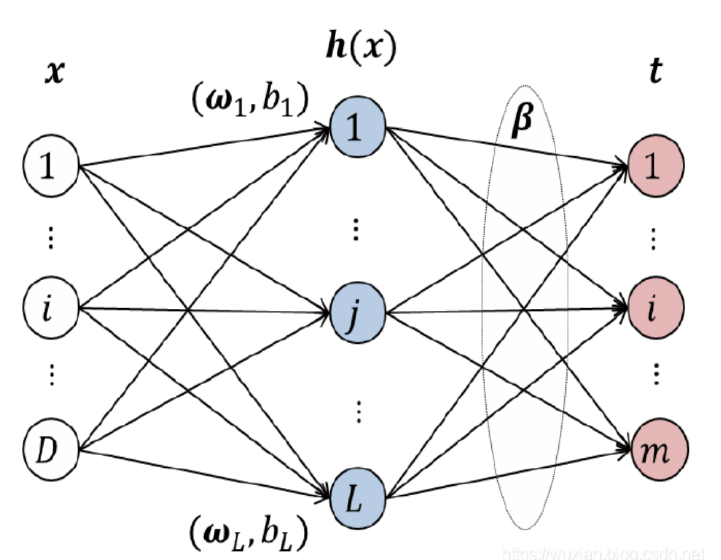
Figure 1. Diagram of the extreme learning machine